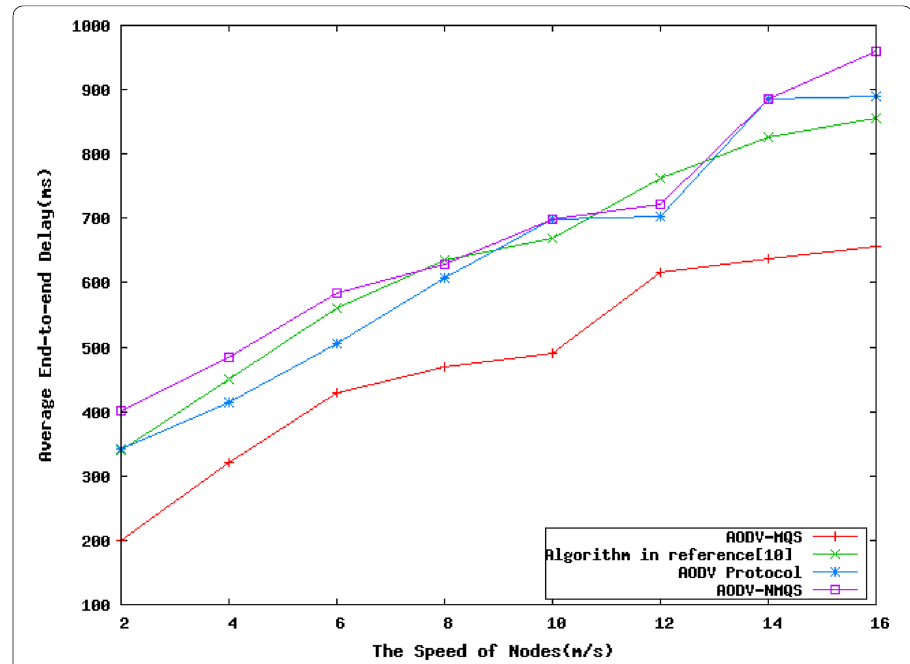
Fig. 7 Comparison of end-to-end delay of four routing algorithms in an unsafe